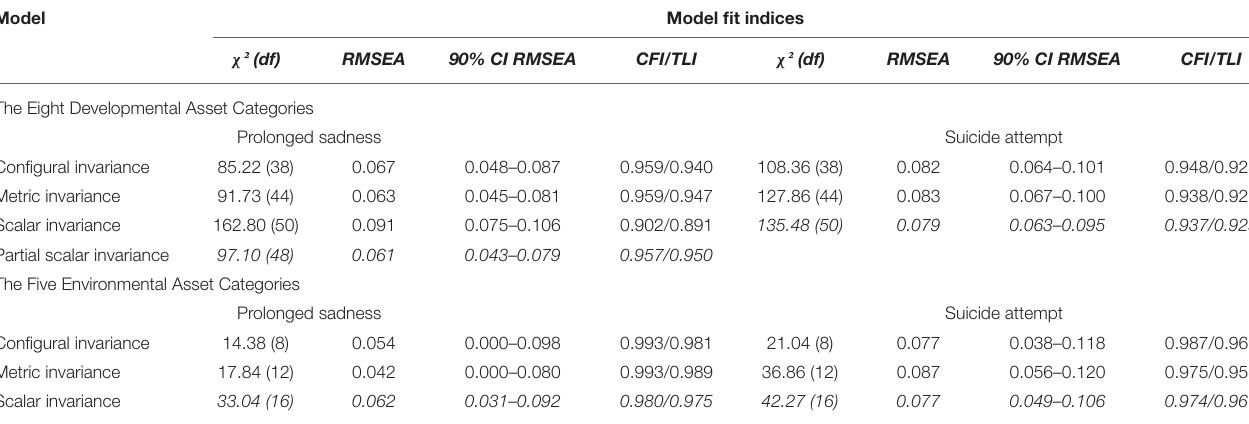
TABLE 2 | Measurement invariance models for developmental assets by mental health indicators.